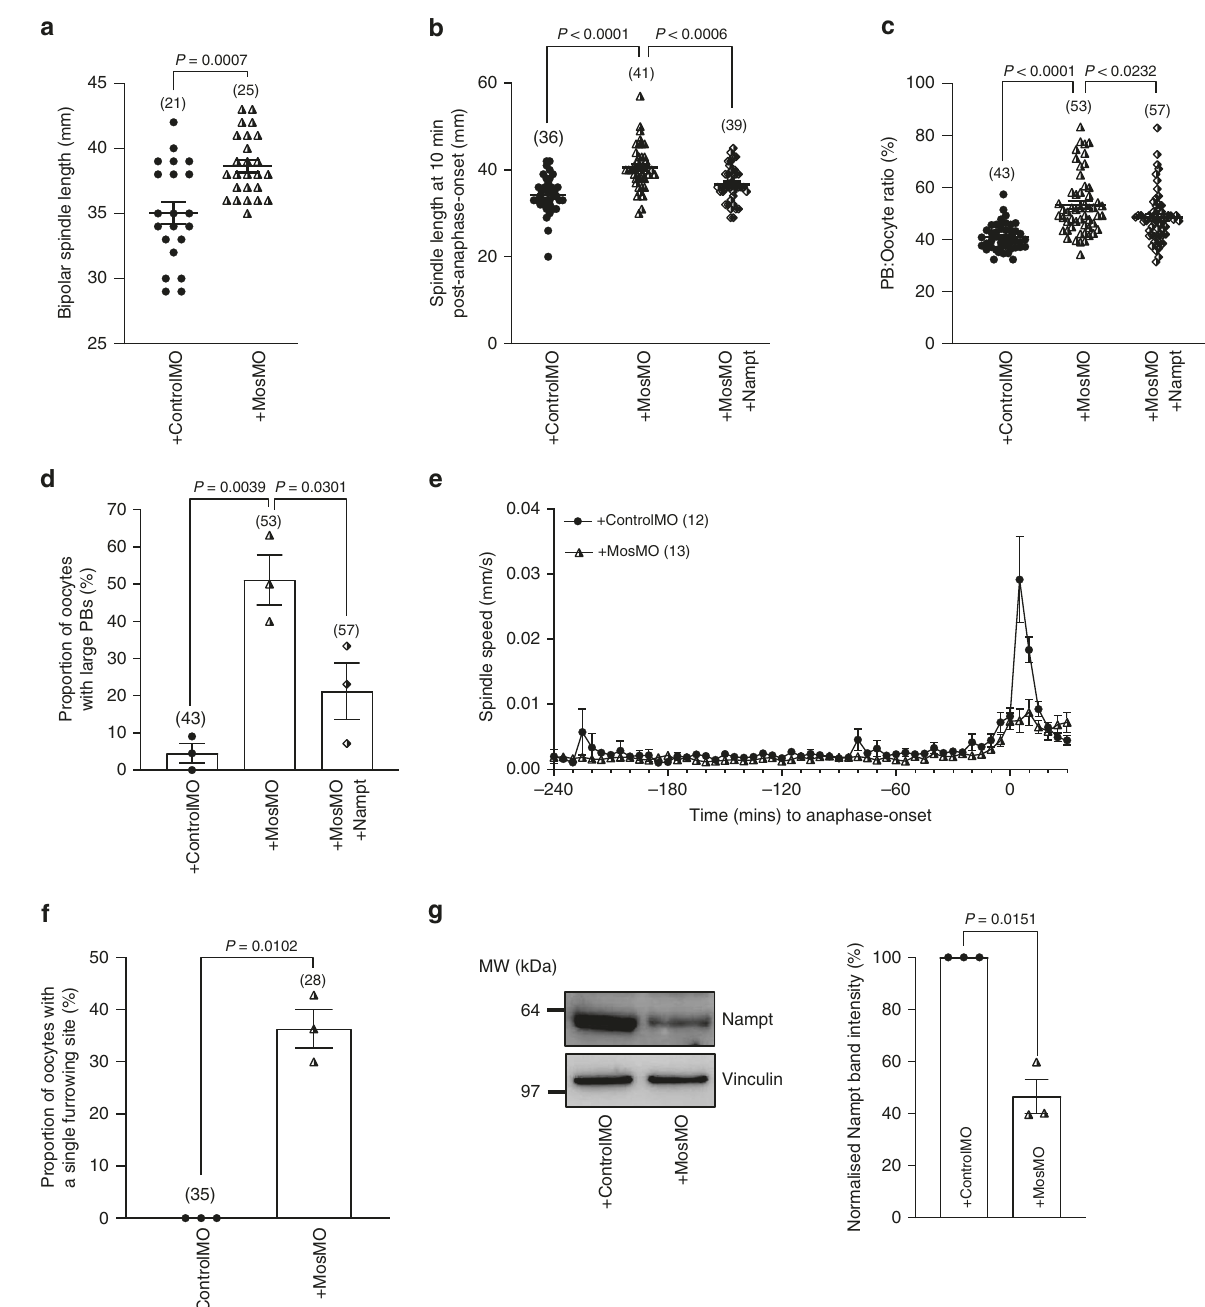
Fig. 7 A Mos – Nampt pathway for asymmetry. a , b Spindle lengths at the time when bipolar spindles fi rst formed ( a ) and 10 min post-anaphase-onset ( b ). c Ratio of PB width to oocyte diameter. d Proportion of oocytes with large PBs. See Methods for further details. e Mean spindle migration speeds relative to anaphase-onset for mock-depleted and Mos-depleted oocytes. f Proportion of oocytes with a single furrowing site. g ControlMO- and MosMO-injected oocytes were immunoblotted for Nampt. Vinculin served as a loading control (left); n = 15 oocytes per lane. Experiments were repeated three times. Quanti fi cation of Nampt protein levels (right). Note that Nampt levels were markedly reduced following Mos-depletion. Oocyte numbers are shown in parenthesis from three independent experiments ( a – f ). Data in graphs are presented as the mean ± SEM. Data points are shown in d , f and g . P -values are shown in the graphs. Statistical comparisons were made using either two-tailed Student ’ s t -test in a , f and g or one-way ANOVA in b – d . Source data are provided as a Source Data fi